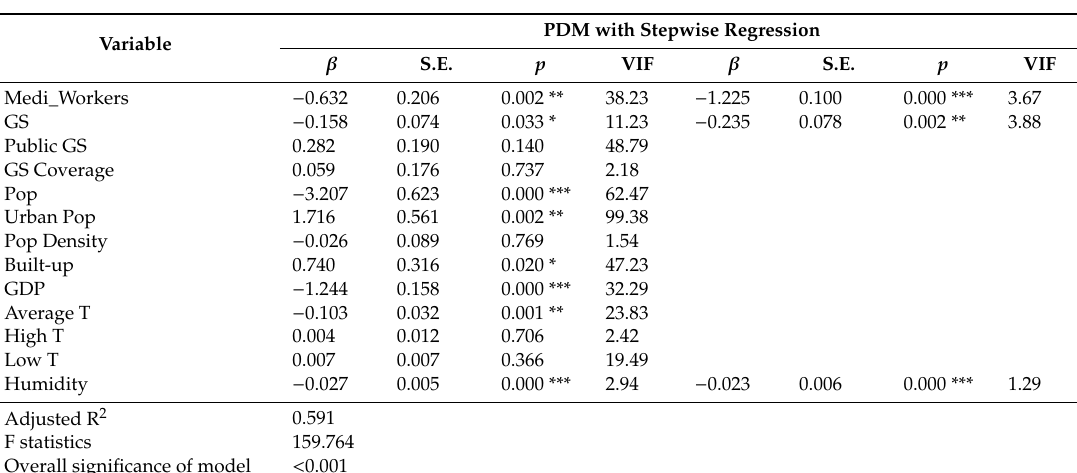
Table 5. Results of Panel Data Model (PDM) of